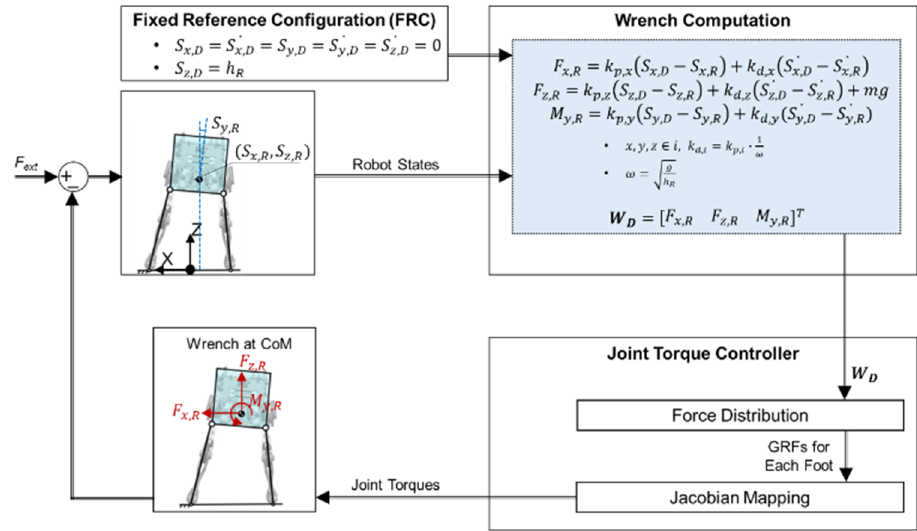
Figure 8. Conventional balance controller using the FRC: Desired wrench at CoM is calculated by simple feedback laws referring to the FRC, unlike the developed balance controller which uses a behavior cloning model.